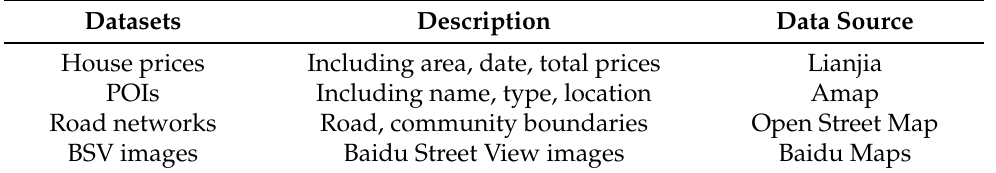
Table 1. Datasets of the study area.